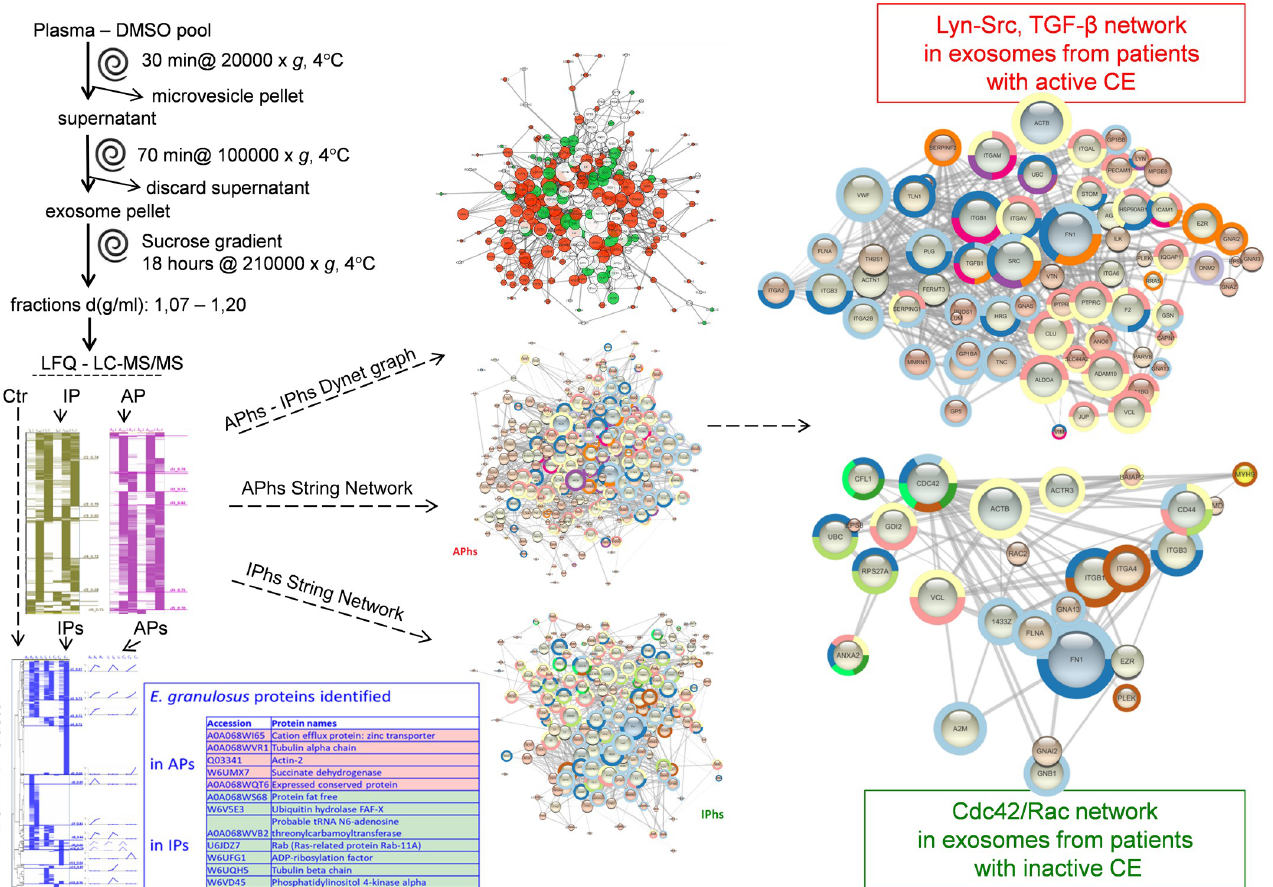
Fig 1. Study Pipeline. Plasma samples preserved in the presence of DMSO were pooled as described in Materials and Methods. Exosome pellets were obtained by differential centrifugation and removal of contaminant plasma proteins was improved by the use of sucrose gradient. Density fractions in the range (1,07– 1,20 ± 0.02) g/ml were further processed for the label-free quantitative (LFQ) proteomics analyses by Liquid-Chromatography Tandem Mass Spectrometry (LC-MS/MS). Identified proteins quantified in at least two replicas (AP, IP) were submitted to hierarchical clustering, and those with Protein Abundance Profiles (PAPs) showing Pearson correlation R � 0.7 (p � 0.05) were selected (APs, IPs) for complete clustering, which included non-filtered control sample proteins (Ctr). Potential biomarkers belonging to E. granulosus were specifically identified in clusters of APs or IPs. Human proteins in APs and IPs (APhs, IPhs) were analyzed to obtain the interaction networks of enriched GO Biological Process and Reactome Pathways for each of APhs and IPhs (String Networks); a graph overlying both APhs and IPhs (Dynet graph) was built, which helped distinguishing between shared and specific proteins among the most central nodes. By analysing these outcomes, we could identify central proteins specifically enriched in exosomes from active or inactive CE, such as SFKs and TGF- β in active CE and Cdc42/Rac in inactive CE.